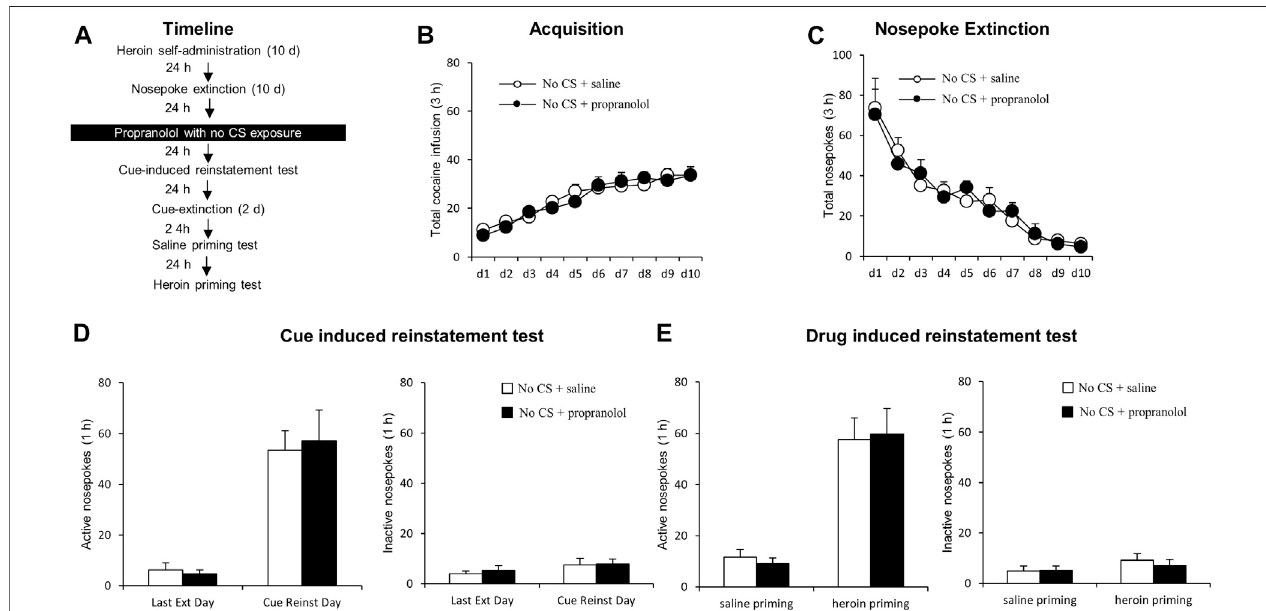
FIGURE 3 | Propranolol treatment without CS reactivation has no effect on subsequent cue-induced and heroin-primed reinstatement of heroin seeking. (A) Schematic representation of the experimental procedure. (B) Total number of infusions across acquisition of heroin self-administration. (C) Total number of active nosepoke responses across extinction sessions. (D) Active (left) and inactive (right) nosepoke responses during the last extinction session and cue-induced reinstatement test. (E) Active (left) and inactive (right) nosepoke responses during the saline-or heroin-primed reinstatement test.